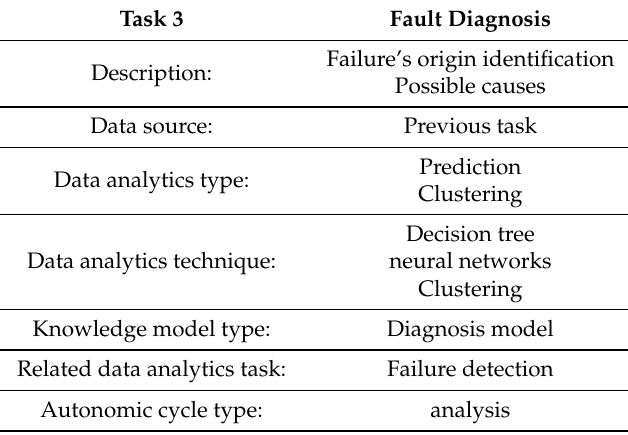
Table 4. Description of Task 3 for